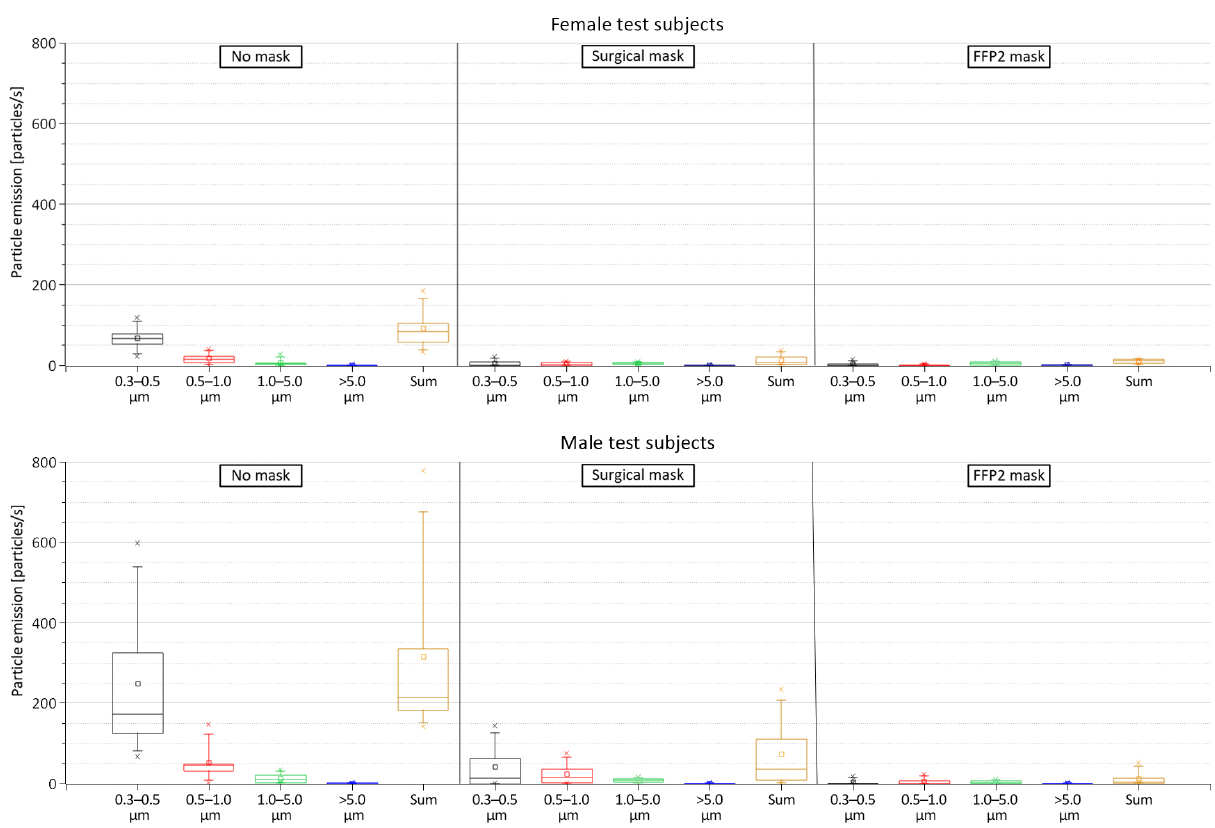
Figure 4. Particle emissions from the female and male test subjects when wearing no mask, surgical mask, and FFP2 mask.